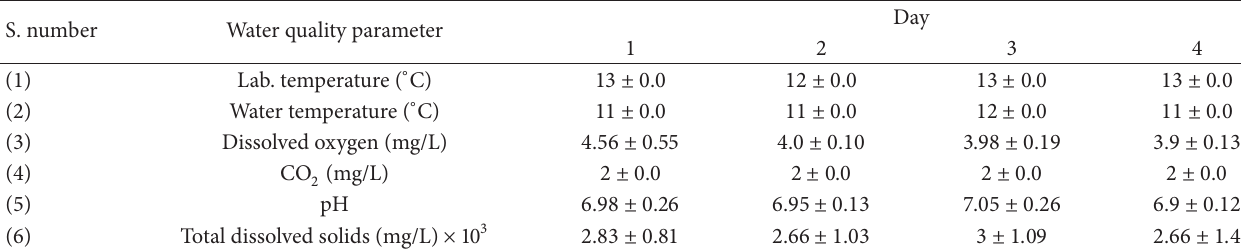
Table 2: Means and SD of water quality parameters of aquarium water during dimethoate bioassay on different intervals. S.